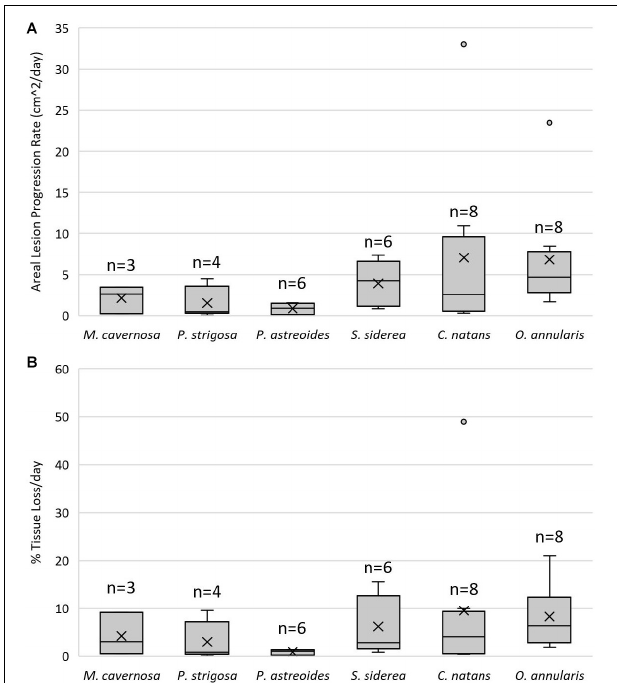
FIGURE 7 | Lesion progression rates. Lower and upper error lines represent the 10th and 90th percentiles, respectively. Shaded boxes represent 25th and 75th percentiles, intersected by a line marking the median. “X” marks the mean and shaded circles represent data outside the 90th percentile. (A) Areal lesion progression rates (cm 2 /day) on coral fragments that exhibited lesions after being exposed to a stony coral tissue loss disease (SCTLD)-affected colony of Diploria labyrinthiformis . (B) Percent tissue loss per day standardized by healthy tissue area (proportional lesion progression rate) of coral fragments that exhibited lesions after being exposed to a SCTLD-affected colony of D. labyrinthiformis